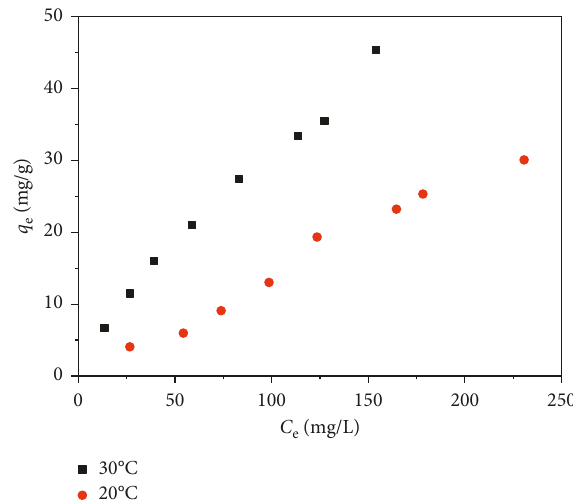
Figure 7: Adsorption isotherm of RR-2 on MOSP-MMT at two temperatures (initial RR-2 concentration: 47.0mg/L reaction time: 10h, and pH: